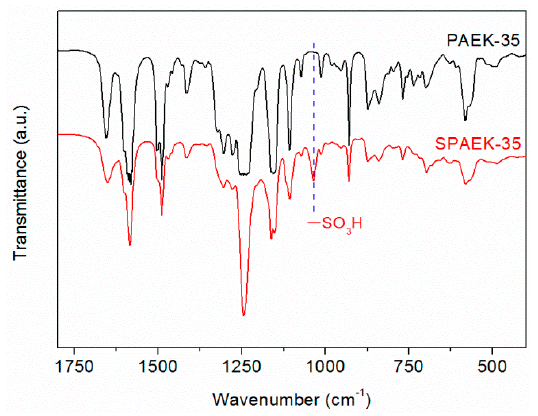
Figure 5. FT-IR spectra of PAEK-35 and SPAEK-35.